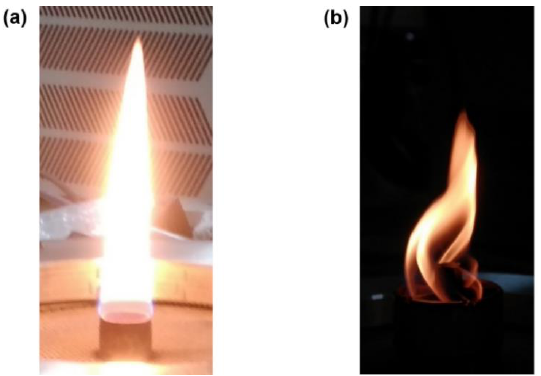
Figure 3. ( a ) Photograph of symmetric flame generated by a Gülder burner. ( b ) Photograph of asymmetric flame generated by mounting of a swirler on top of the burner nozzle shown in ( a ).